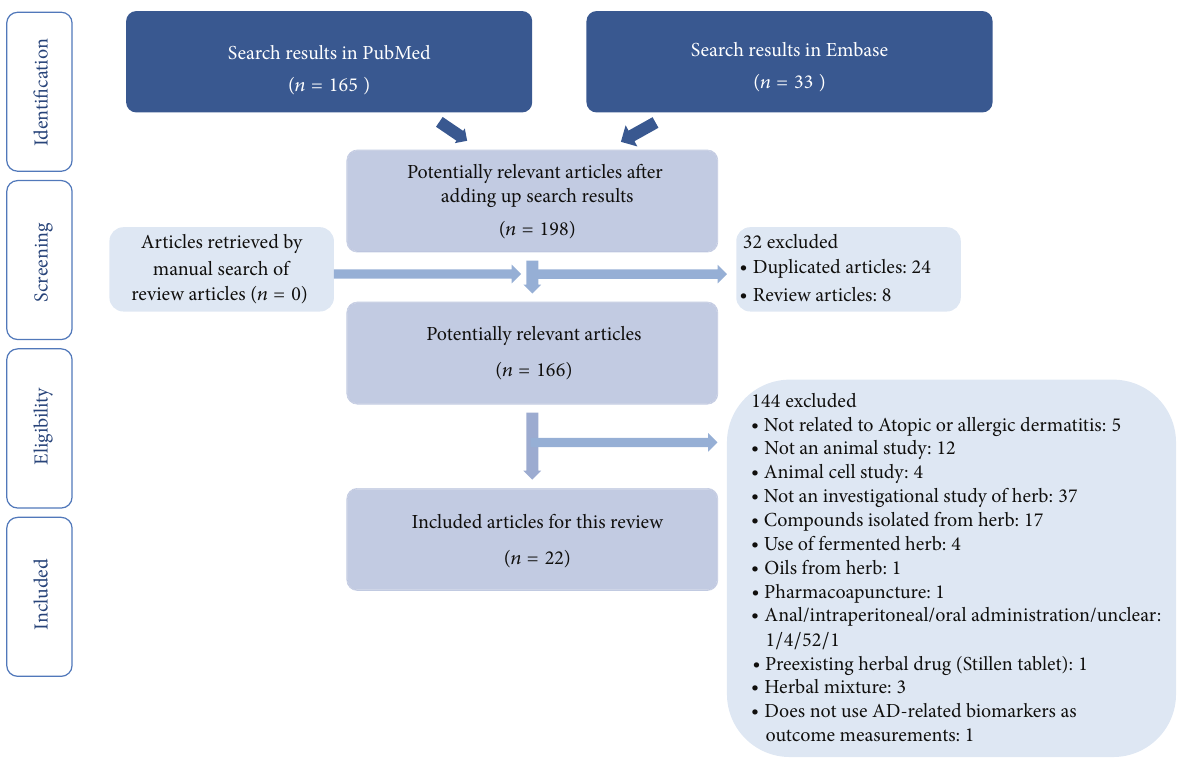
Figure 1: Flowchart of the study selection